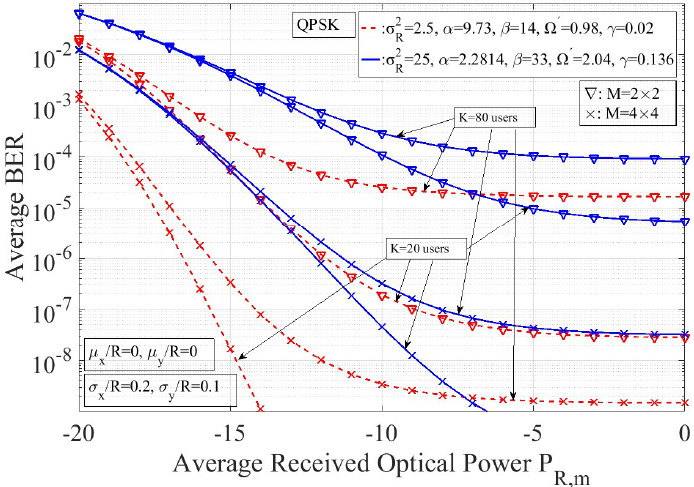
Figure 6. The ABER performance for the reverse CDMA RoFSO link with receivers’ diversity, over strong turbulence and enhanced PE impact for different values of the number of users K . Eventually, the OP outcomes are depicted in Figures 7 and 8. It is worth noting that the outage performance estimation is implemented as a function of the CNIR k,m,EX , providing the advantage for performance assessment of both directions of the forward and the reverse link. Compared to the case of the P2P link, [18], the OP touches significantly lower values and the availability of the link increases. The threshold value for the CNIR k,th per diversity branch is fix equal to 10 dB. In the case of M = 4 × 4, the spatially diverse link performs very well even at saturated turbulence conditions with values of the CNIR k,EX per branch at 20 dB for both directions of the forward and the reverse link.